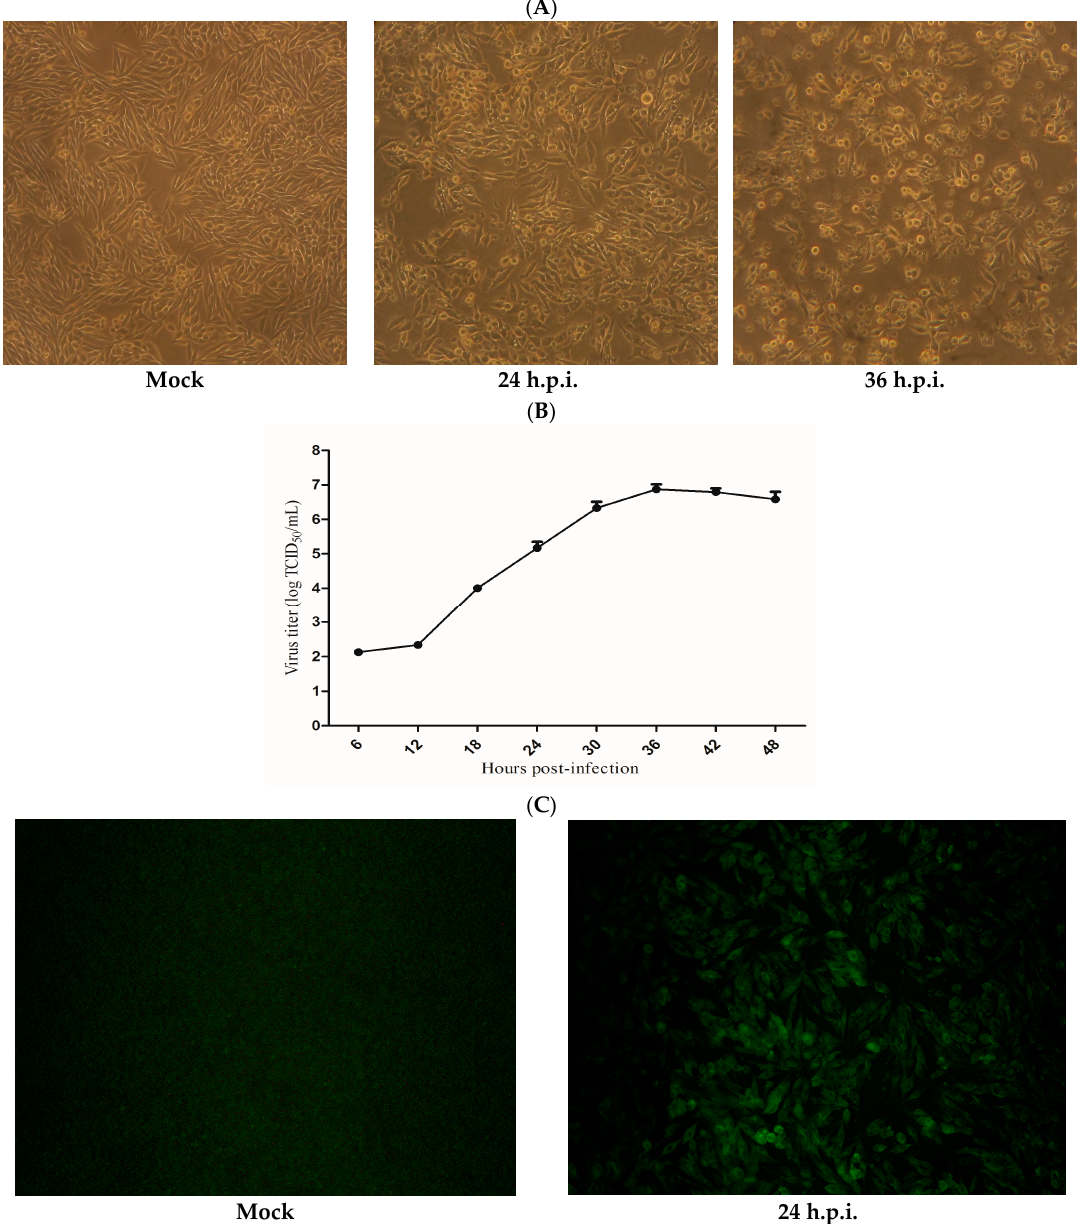
Figure 1. Susceptibility of HD11 to infectious bronchitis virus (IBV) Beaudette infection. ( A ) Cytopathic effects (CPE) observed upon IBV Beaudette infection by 24 and 36 h post-infection (h.p.i.), and mock-infected HD11 cells displayed no CPE. ( B ) Growth kinetics of IBV Beaudette in HD11 cells infected at 10 multiplicity of infection (MOI). Data are shown as the mean ± standard error of the mean (SEM) of three independent experiments. ( C ) Production of IBV Beaudette (fluorescein isothiocyanate, FITC) could be observed at 24 h.p.i., and mock-infected HD11 cells showed no fluorescence.